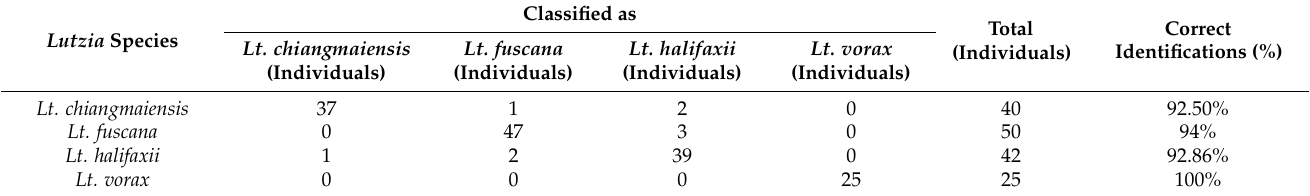
Table 3. Identification error and percentage of correct classification based on the wing shape of Lt. chiangmaiensis , Lt. fuscana , Lt. halifaxii , and Lt. vorax calculated by a cross-validated reclassification test.